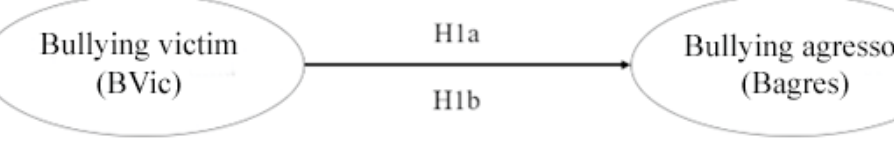
Table 1. Distribution of participants by city.